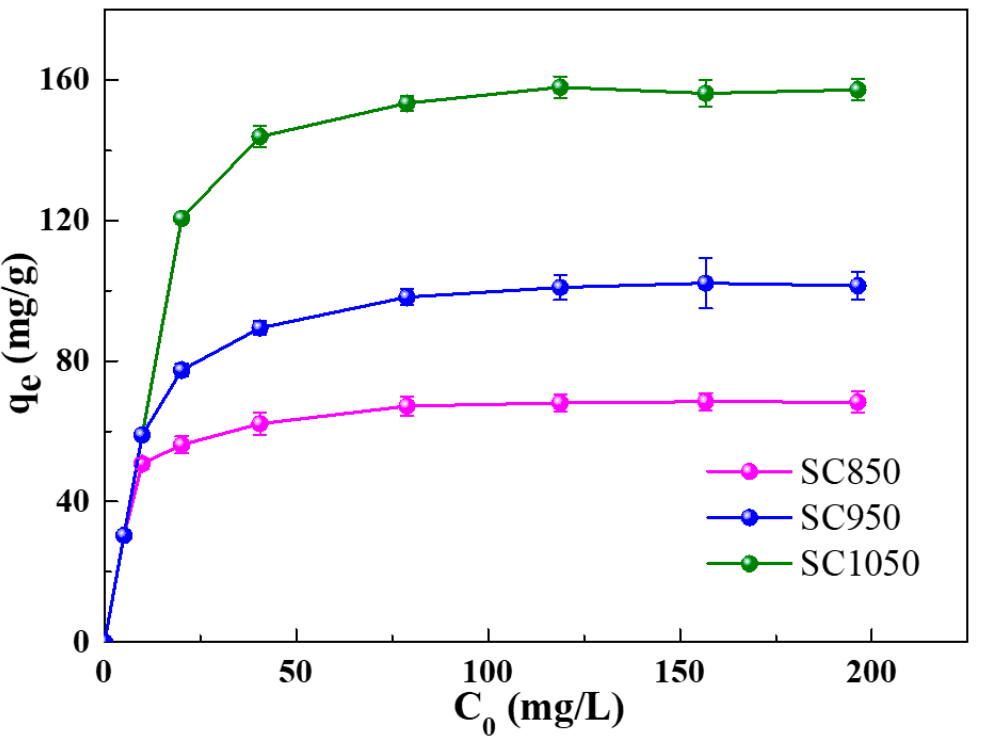
Figure 7. Effect of initial MB concentration on the adsorption process.